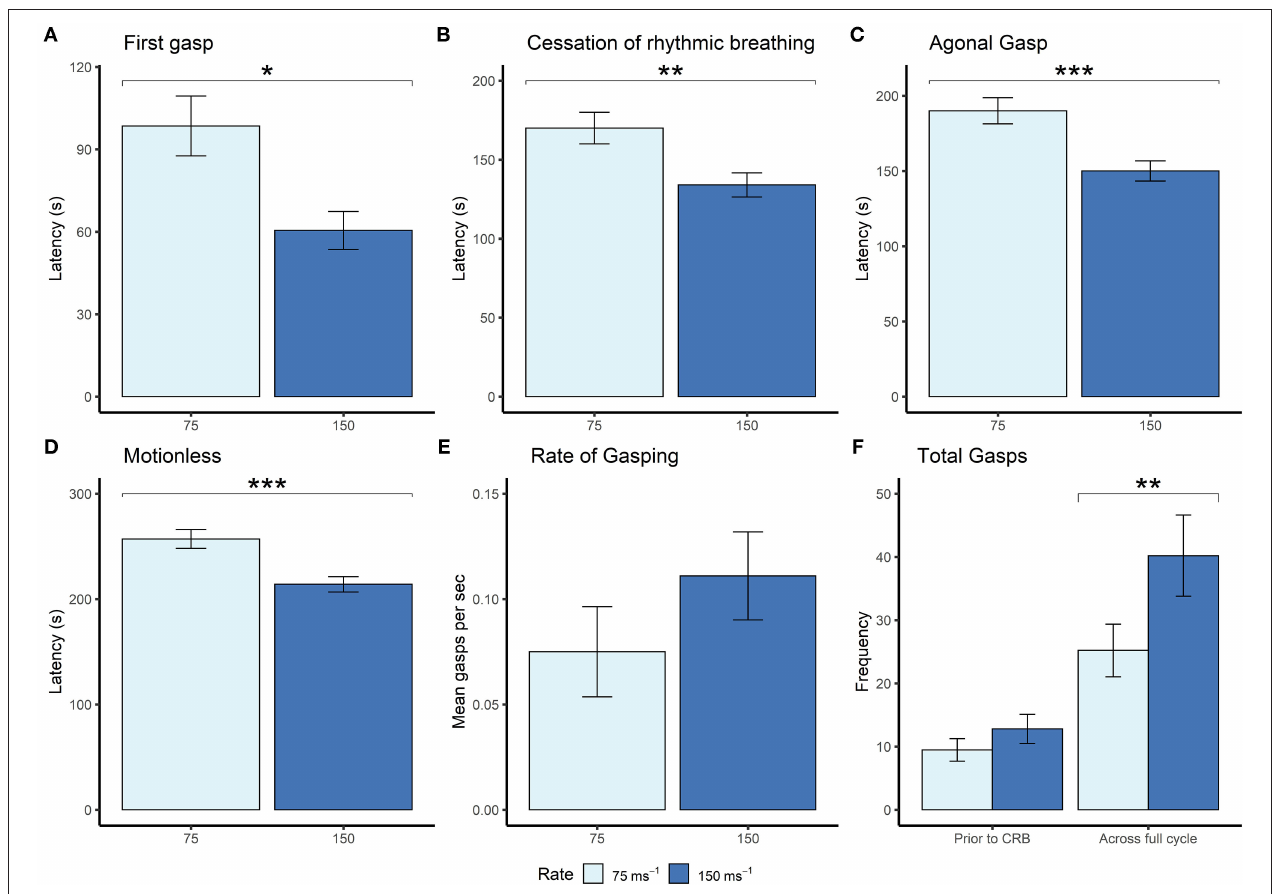
FIGURE 3 | Mean ( ± SE) (A) latencies to first gasp (75 ms − 1 n = 35; 150 ms − 1 n = 37), (B) latencies to cessation of rhythmic breathing (75 ms − 1 n = 35; 150 ms − 1 n = 37), (C) latencies to agonal gasping (75 ms − 1 n = 33; 150 ms − 1 n = 37), (D) latencies to motionless (75 ms − 1 n = 34; 150 ms − 1 n = 37), and (E) rate of gasping (frequency per second) prior to cessation of rhythmic breathing, and (F) frequencies of gasps occurring prior to cessation of rhythmic breathing (prior to CRB) and the whole decompression cycle length (across full cycle; 75 ms − 1 n = 35; 150 ms − 1 n = 37) according to overall decompression rate [75 ms − 1 (light blue) and 150 ms − 1 (dark blue)]. * p < 0.05, ** p < 0.01, *** p <